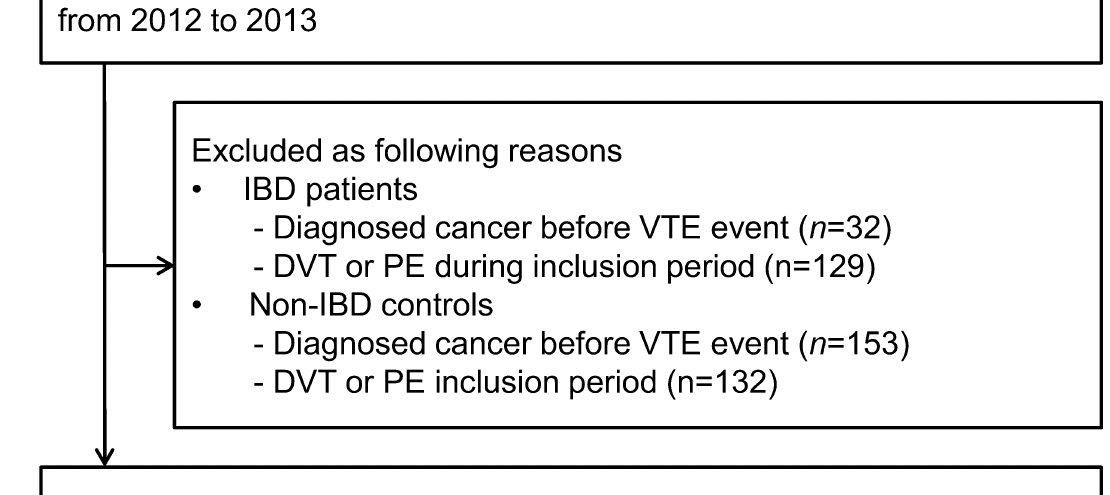
Figure 1. Flow chart of study